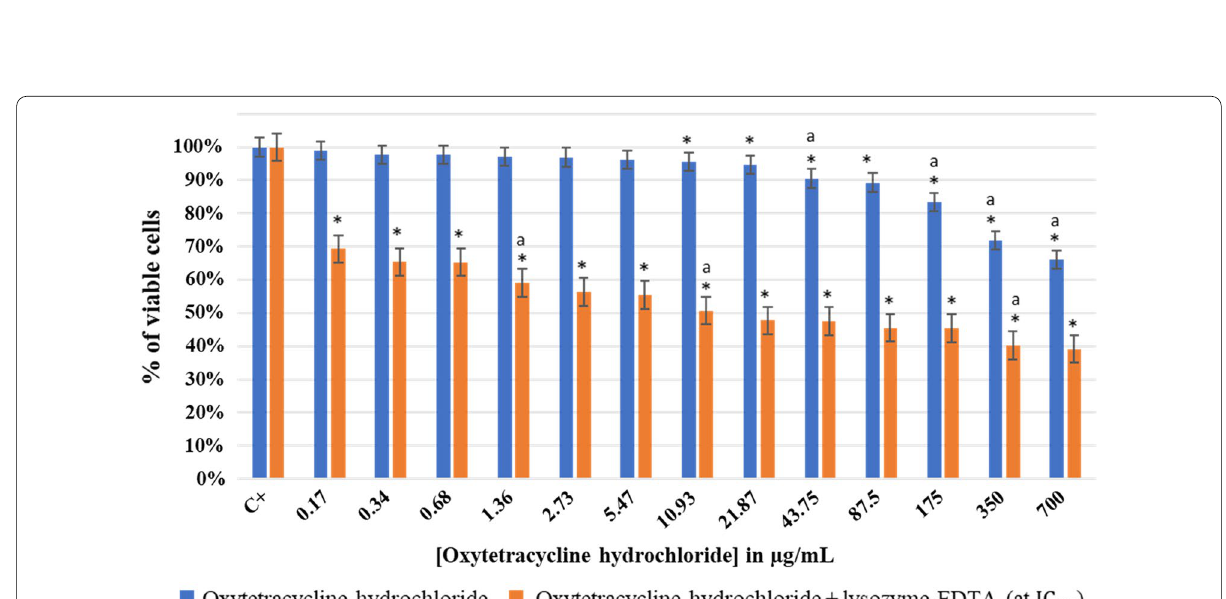
Fig. 6 Effect of oxytetracycline hydrochloride with and without lysozyme-EDTA (at IC 50 ) on the planktonic co-culture of Lactobacillus rhamnosus GG and Staphylococcus epidermidis 444. OD 600 negative control (oxytetracycline hydrochloride) 0.32. OD 600 of 700 μg/mL of oxytetracycline = hydrochloride with lysozyme-EDTA (at IC 50 ) 0.30. The results are mean values of three replicates. (*) indicates a significant difference (P < 0.05) = between each test and the positive control (oxytetracycline hydrochloride). The lowercase letter a indicates a significant difference (P < 0.05) between each test and its preceding. Error bars represent the SD (standard